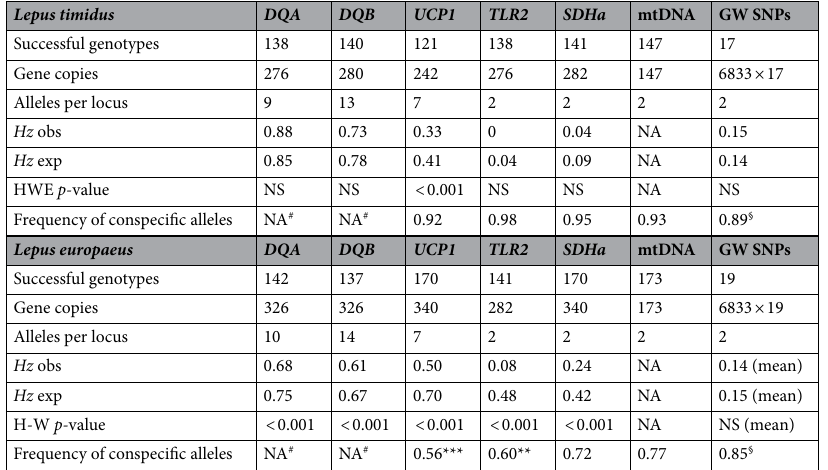
Table 1. An overview of the of the genotyping results for 147 Finnish mountain hares ( Lepus timidus ) and 173 Finnish brown hares ( Lepus europaeus ) showing the number of genotype gene copies, alleles per locus, observed as well as expected heterozygosity frequency ( Hz ) and the statistical significance for the deviation from Hardy–Weinberg equilibrium (HWE). NS = not significant and NA = not applicable. For example, mitochondrial DNA (mtDNA) is haplotypic and therefore no Hz can be computed. Χ 2 test against mtDNA introgression alone: ** p < 0.01, *** p < 0.001. # No species-specific alleles could be assigned. § Expressed as proportion of membership of pre-defined population (brown hare or mountain hare) in STRU CTU RE analysis 86 (See 45 ). GW genome wide.